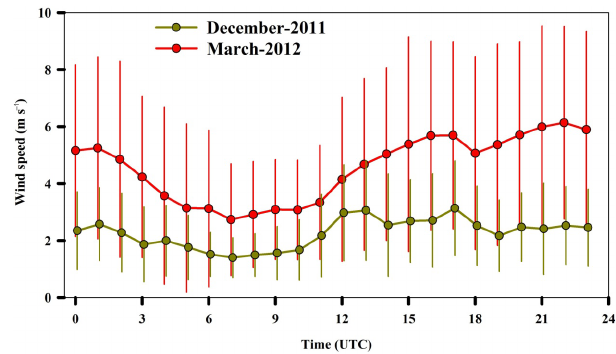
Figure 6. The monthly average diurnal variation in surface wind speed over the site during the clear sky days, selected for estimation of the mixed layer height as depicted in Fig.